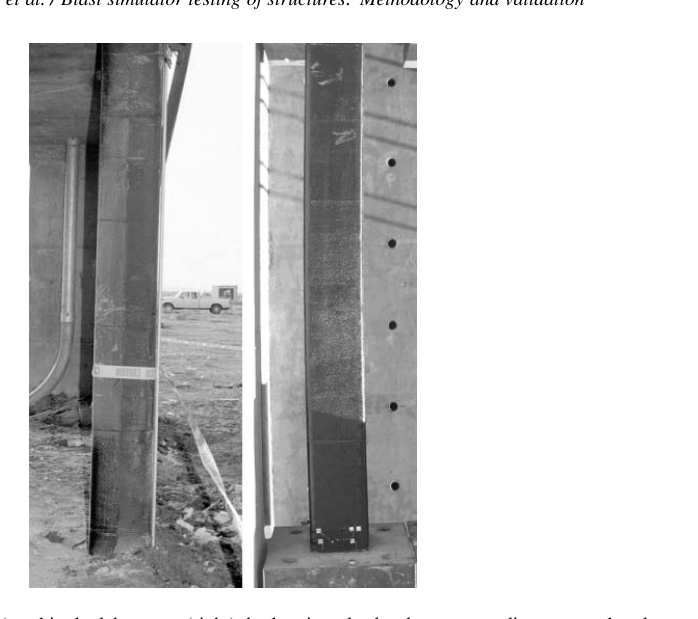
Fig. 7. CSS columns tested in the fi eld (left) and in the laboratory (right), both at impulse levels corresponding to a car bomb at curbside [18].